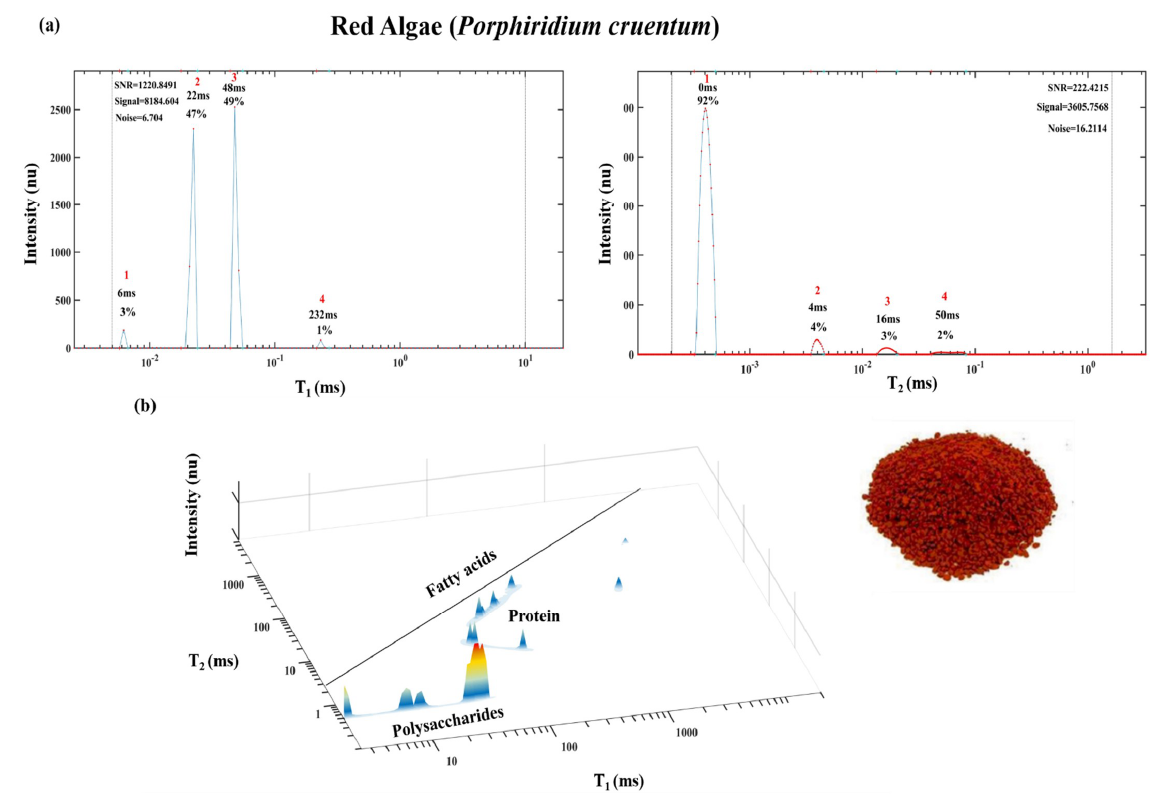
Figure 9. One‐dimensional T 1 and T 2 spectra of sesame seeds ( Sesamum indicum ) ( a ) and 2D T 1 ‐T 2 spectra ( b ). Image of sesame seeds (bottom right).